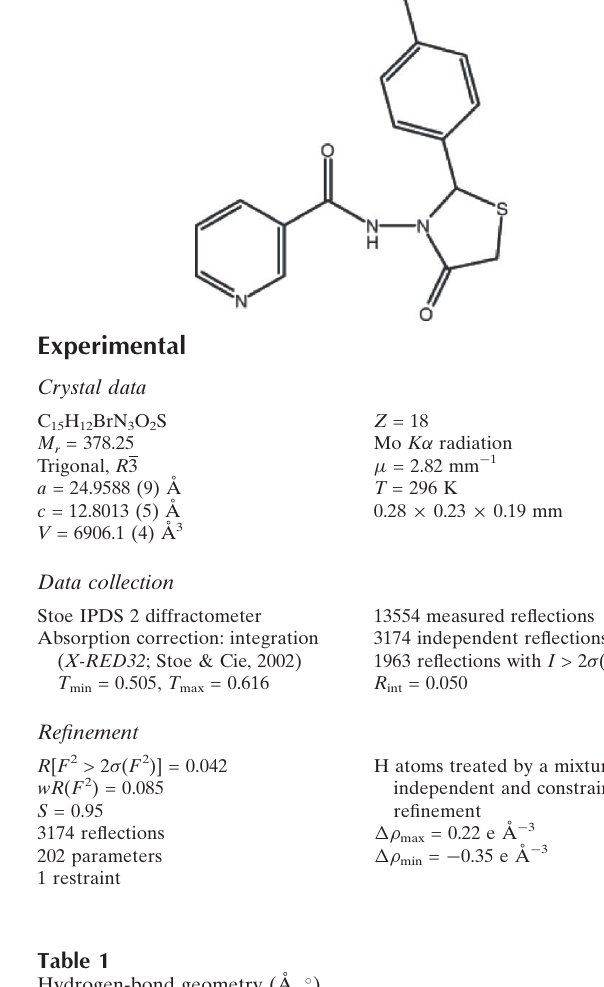
Hydrogen-bond geometry (A˚ , (cid:2) ). Cg 3 is the centroid of the C1–C6 benzene